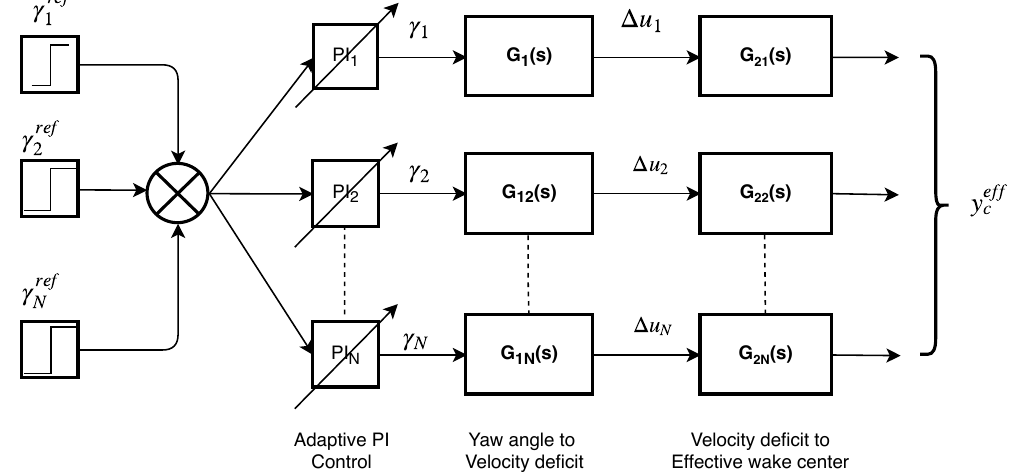
Figure 3. Wake center estimation based on transfer function in case of multiple wake